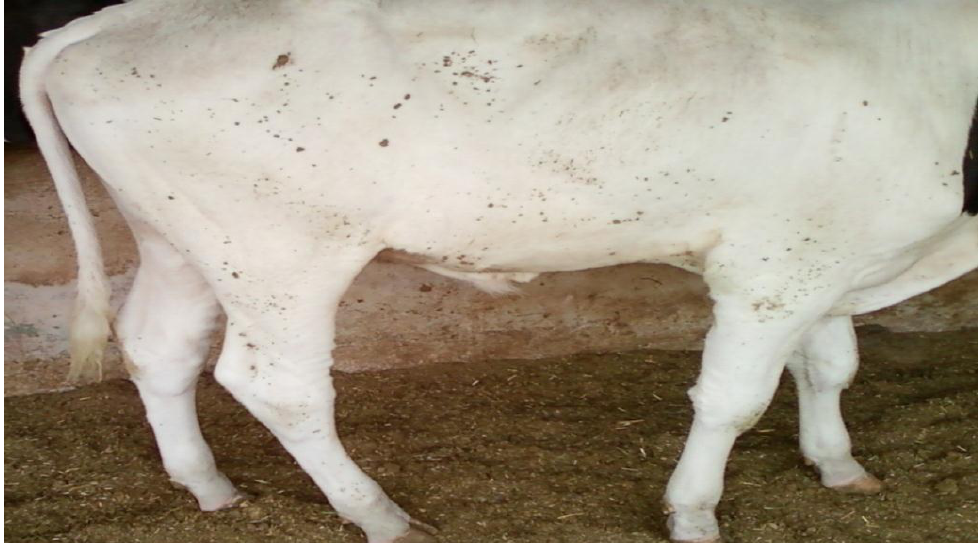
Figure (1): Muscle stiffness, and lameness in right forelimb and hind limb